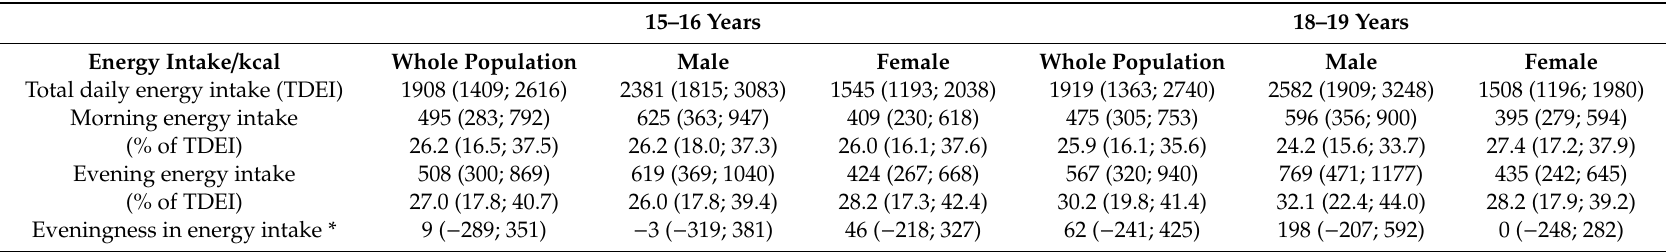
Table 3. Total daily energy intake, energy intake distribution and eveningness in energy intake according to age and